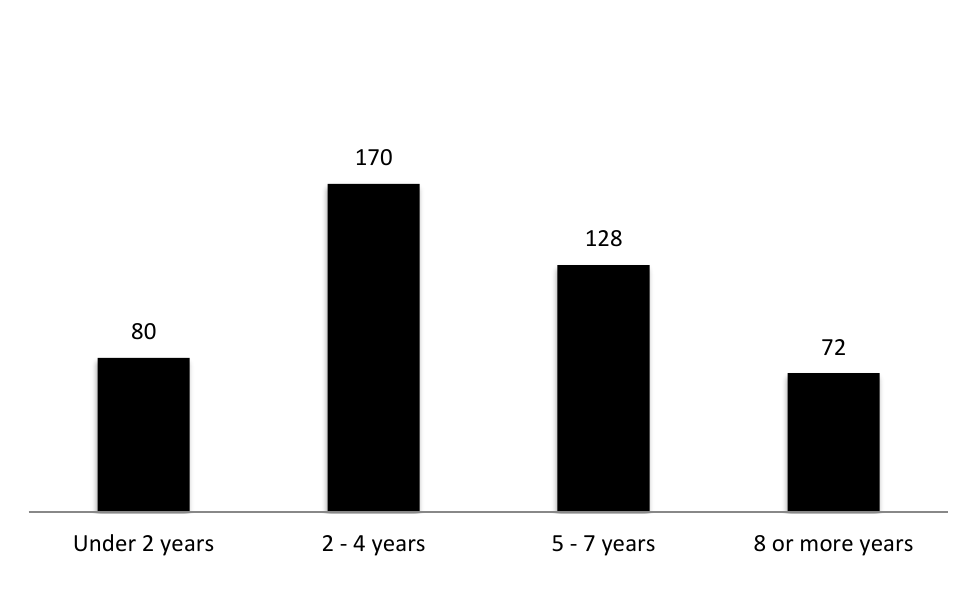
Figure 3: Use of VLE in years 67% of respondents (n=355) indicated they had received training in using the VLE, 33% (n=172) indicated they had not (Figure 4). This finding has implications for the supports offered to staff and the lack of opportunities and/or time to engage in development.